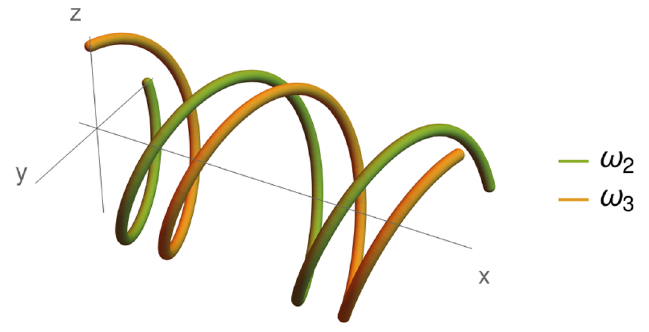
, (5.2). The phase shift between them is , ω ( p c ) 2 3